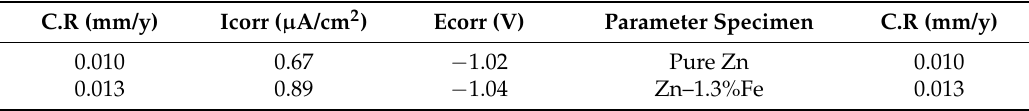
Figure 7. Potentiodynamic polarization curves obtained in PBS solution. Table 3. Corrosion potential (E corr ), corrosion current (I corr ) and corrosion rate (C.R.) obtained by Tafel extrapolation from polarization curves shown in Figure 7.